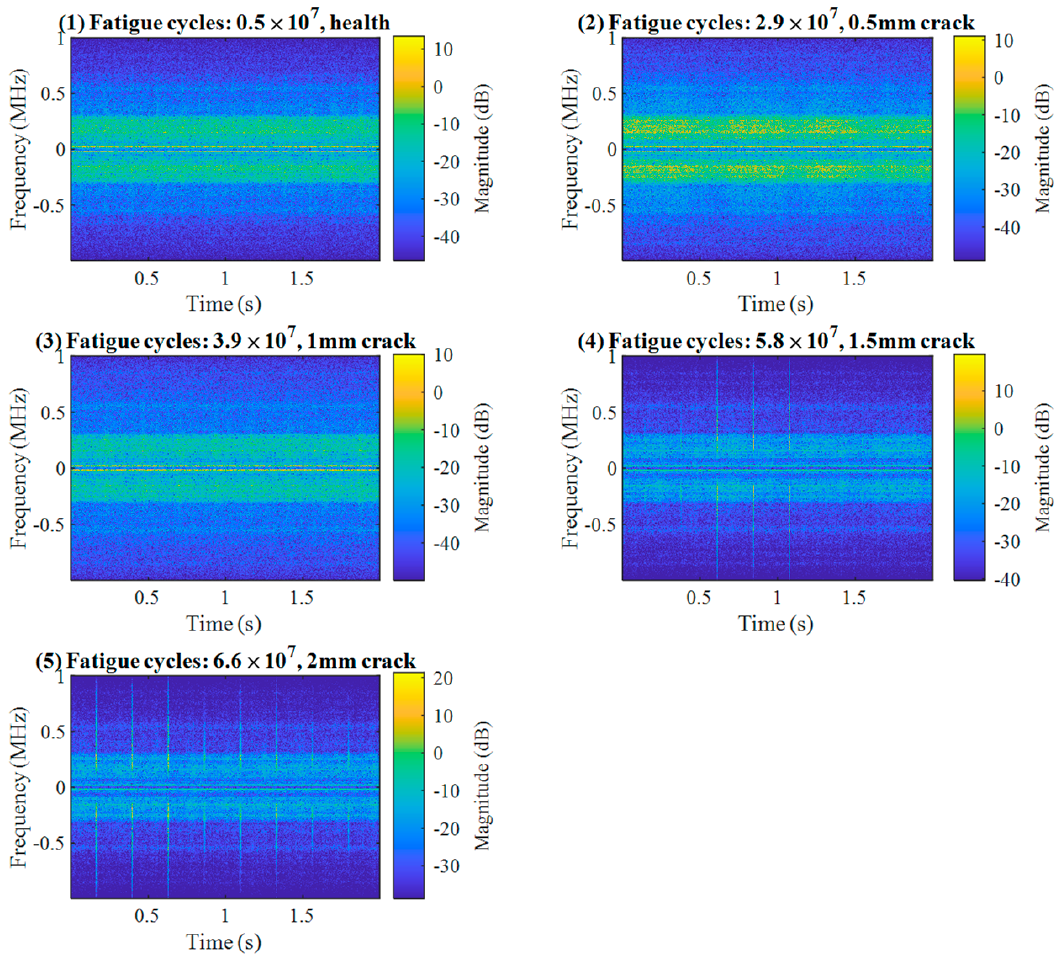
Figure 9. Representative time–frequency spectral decompositions of AE signals corresponding to different stages of damage propagation.